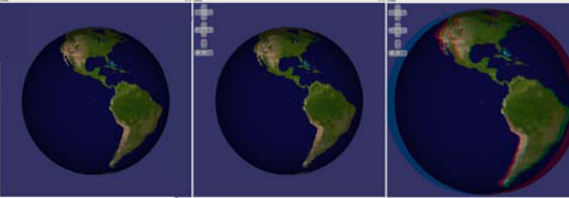
The users could not identify complex patterns immediately, but